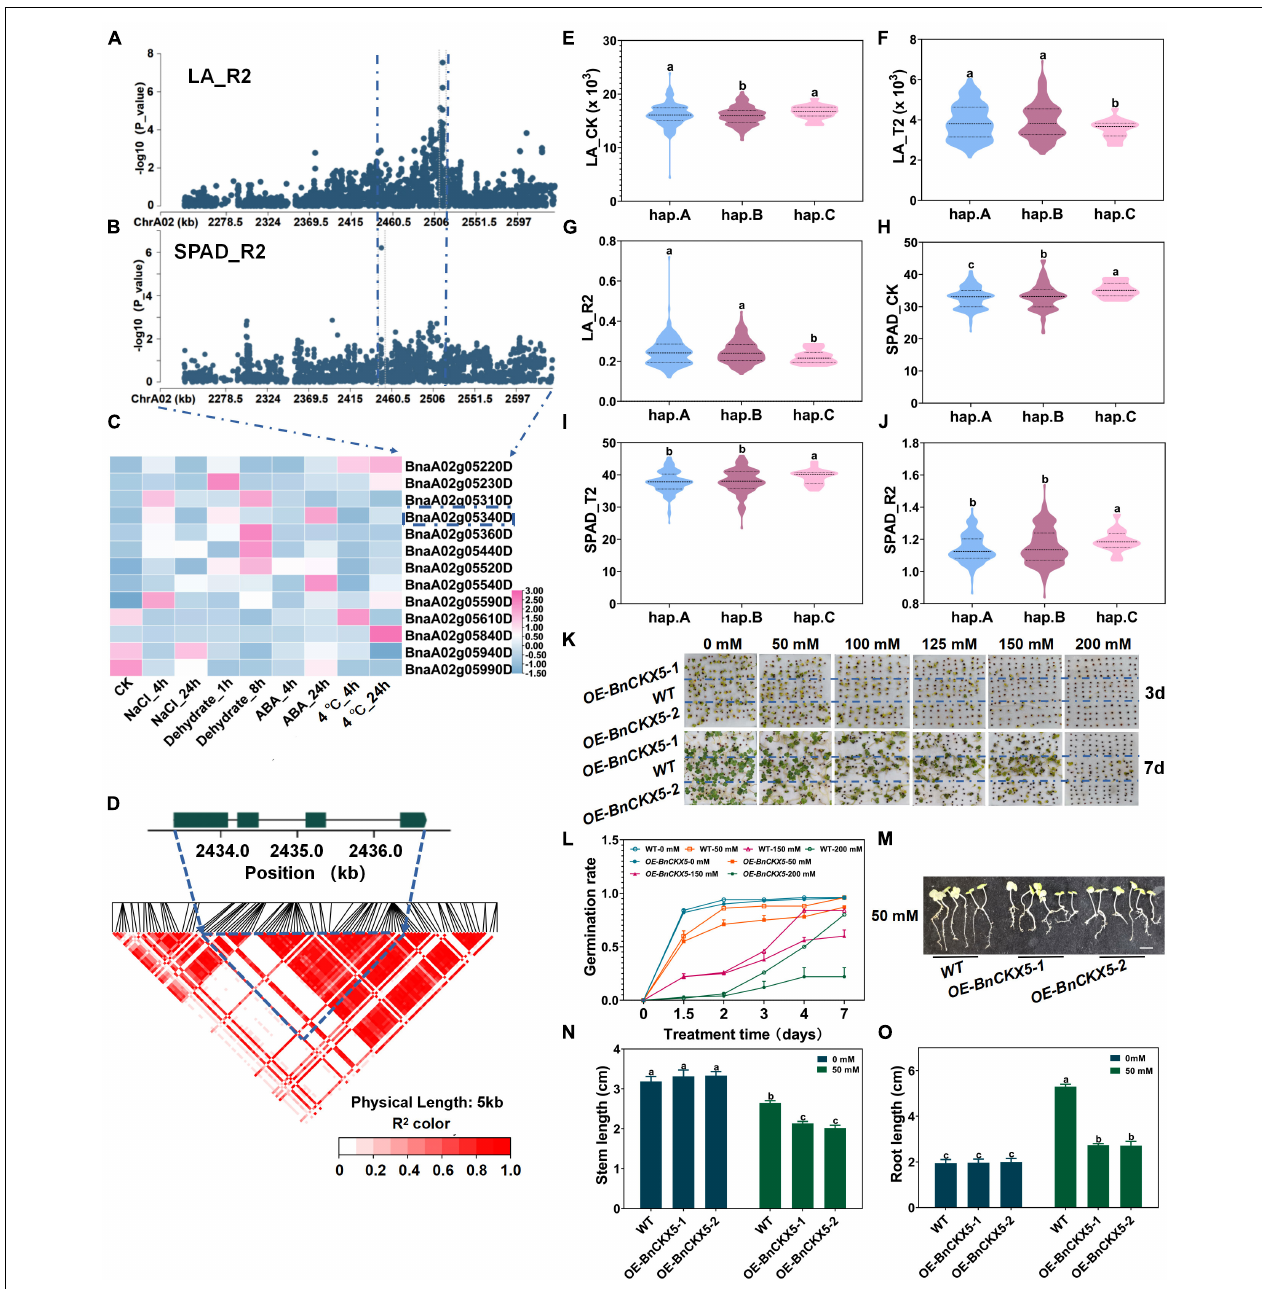
FIGURE 3 | Gene location and function research of BnCKX5 under salt stress. (A) Zoom-in of the Manhattan plot on ChrA02 with co-localized locus. These points represented the log-transformed P -values for variants from GWAS of root length (RL_R1) at the germination stage. (B) Zoom-in of the Manhattan plot on ChrA02 with co-localized locus. These points represented the log-transformed P -values for variants from GWAS of chlorophyll content (SAPD_R2) at the seedling stage. (C) Gene expression of candidate genes identified within 200kb upstream or downstream of the associated SNPs under 200 mM NaCl, 25 µ M ABA or 4 ◦ C low-temperature stress for 4 and 24h and dehydration condition for 1h and 8h in B. napus cultivar Zhong Shuang 11 (‘ZS11’). (D) LD heatmap within 1kb upstream or downstream of BnCKX5 . (E–G) Boxplots of haplotypes for the absolute and relative value of the root length (RL) at germination stage (RL_CK, E ; RL_T1, F ; and RL_R1, G ). Values were means ± SD and different letters indicate differences at P ≤ 0.05 using two-way ANOVA. (H–J) Boxplots of haplotypes for the absolute and relative value of different stress conditions and control with the chlorophyll content (SPAD) at seedling stage (SPAD_CK, H ; SPAD_T2, I ; and SPAD_R2, J ). Values were means ± SD ( n = 6 replicates) and different letters indicate differences at P ≤ 0.05 using two-way ANOVA. (K,L) Comparison of the germination rate (FYL, K , L ) of wild type (Westar) and BnCKX5 overexpression ( OE-BnCKX5 ) under control and salt (0, 50, 100, 125, 150, 175, 200, 225, and 250 mM NaCl) conditions. Values were means ± SD ( n = 2 replicates). (M–O) Comparison of the shoot length (SL, N ) and root length (RL, O ) of wild type (Westar) and BnCKX5 overexpression ( OE-BnCKX5 ) under control and salt (0, 50, 100, 125, 150, 175, 200, 225, and 250 mM NaCl, M ) conditions. Scale bar = 1.5 cm. Values were means ± SD ( n = 6 replicates) and different letters indicate differences at P ≤ 0.05 using two-way